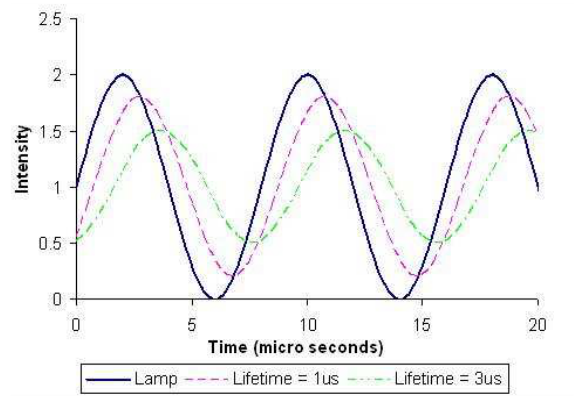
Figure 16. Phase shifts for different